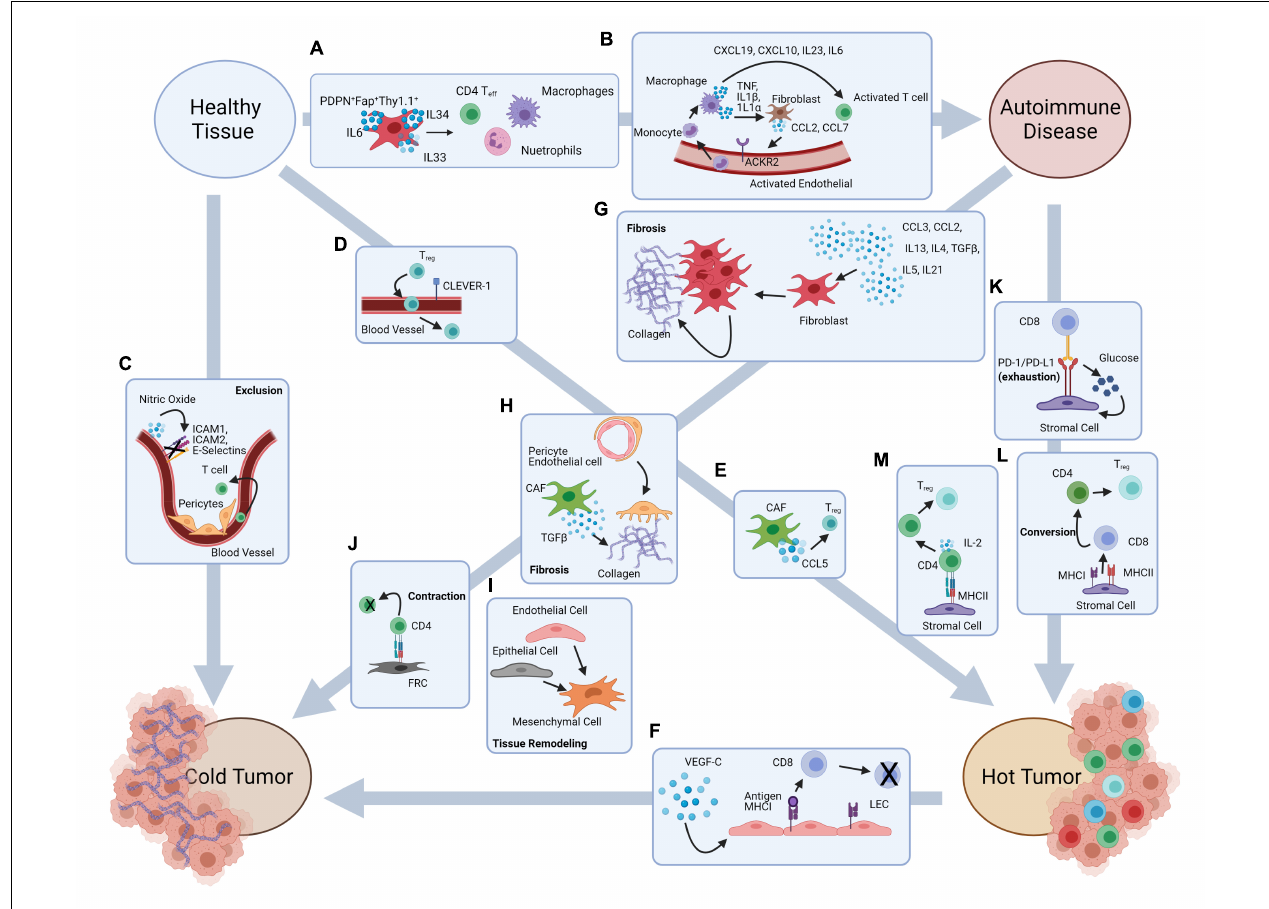
FIGURE 2 | Stromal cell-mediated potential mechanisms underlying the putative pathways from autoimmune damage to cancer development. Autoimmune disease onset and cancer development are both characterized by inflammation and immune dysregulation. Literature evidence suggests some putative pathways that may associate autoimmunity and cancer development, and possibly explains the autoimmune etiology in some types of cancer. (A) Fibroblasts contribute to the recruitment of inflammatory cells in autoimmune disorders such as RA. (B) Activated fibroblasts and endothelial cells contribute to inflammation within the large intestine. (C) Abnormal BEC structure and pericyte interactions lead to T cell exclusion in the TME, while NO production downregulates the expression of adhesion markers on blood vasculature. (D) CLEVER-1 expression by blood vessels leads to T reg recruitment into the TME. (E) CCL5 production by CAF contribute to T reg recruitment into the TME. (F) VEGF-C production increases LEC proliferation and antigen presentation leading to CD8 T cell apoptosis. (G) Inflammatory signals lead to fibroblast proliferation and collagen production causing fibrosis. (H) Pericyte transition into fibroblast like cells and TGF β expression by CAF contributes to fibrosis. (I) Endothelial cell to mesenchymal cell transition and epithelial to mesenchymal cell transition. (J) Antigen presentation by FRC leads to CD4 T cell contraction. (K) PD-1/PD-L1 interactions leads to metabolic reprograming in both CD8 T cells and stromal cells. (L) MHCI and MHCII expression by stromal cells contributes to CD8 to CD4 lineage conversion. (M) Antigen presentation to CD4 T cells by stromal cells leads to T reg